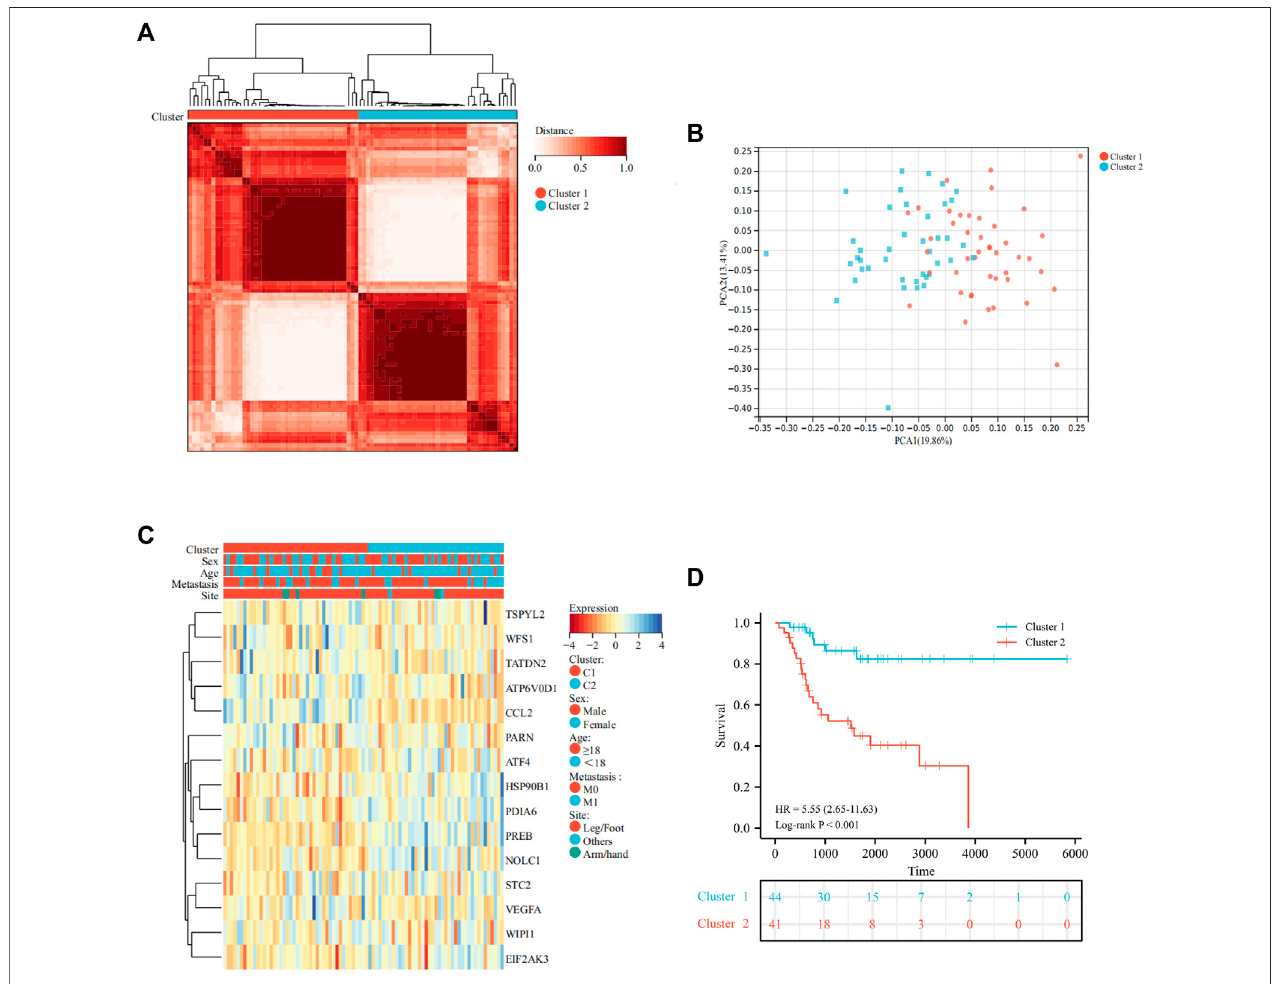
FIGURE1| Identi fi cationofmolecularsubtypesofUPRRGsbyconsensusclustering. (A). Clusteringheatmapatk=2. (B) PCAplotbetweenthetwosubtypes. (C) Heat map of the UPR-related gene expression and clinical features in the two subtypes. (D) Survival curves for the two subgroups.